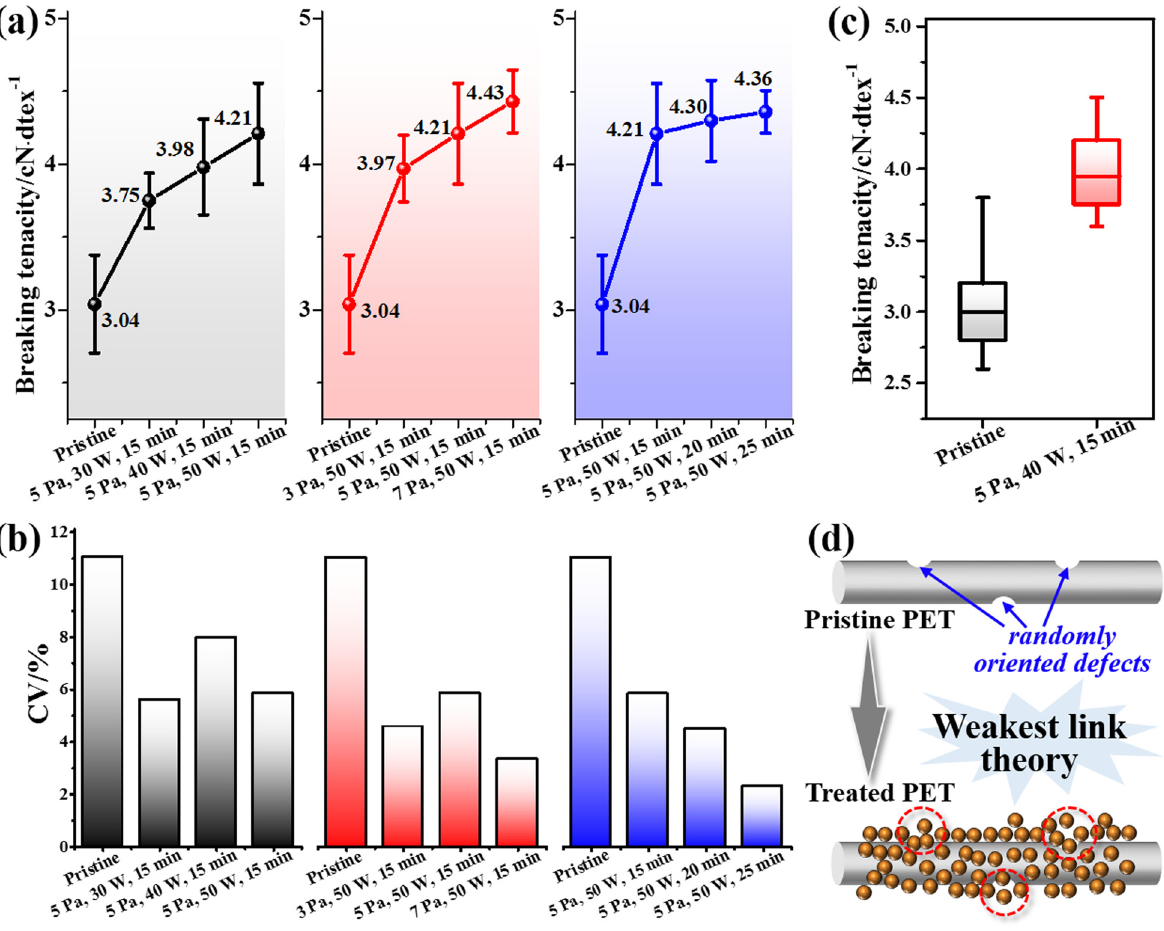
Figure 4: E ff ects of technological parameters on ( a ) tensile tenacity and ( b ) CV% of SS - sputtered PET fi bers; ( c ) boxplots for quantifying tensile strength; and ( d ) strength reinforcing